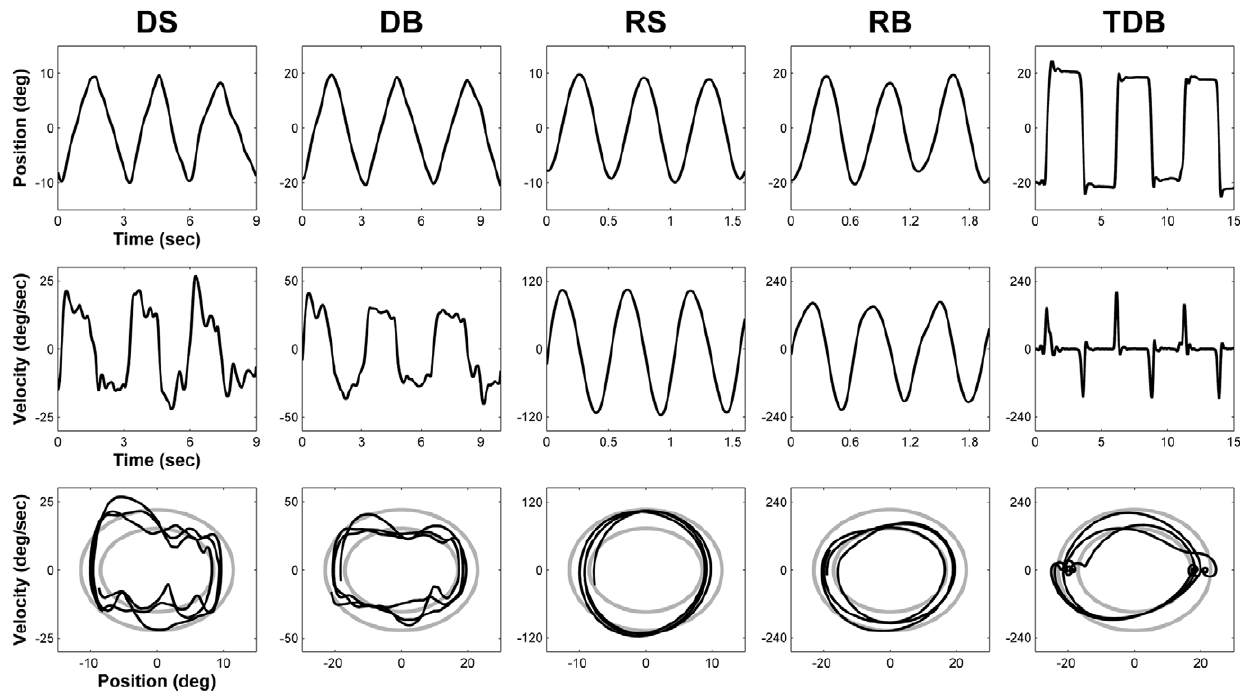
Figure 3. Examples of movement trajectories and phase-plane display for the five experimental conditions. Top panels: position as a function of time. Middle panels: velocity as a function of time. Bottom panel: the display of the allowed range as seen on the computer screen is shown in gray, –and the phase-plane trajectory is shown in black.